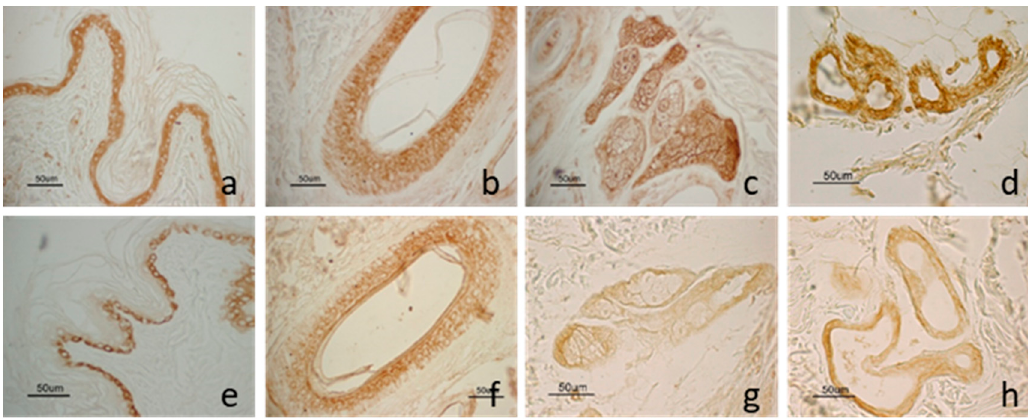
Figure 2. LEP and LEPR immunostaining in dog skin: LEP immunostaining in the epidermis ( a ); in the outer root cells of the hair follicle isthmic region ( b ); in the sweat gland ( c ) and the sebaceous gland ( d ). LEPR immunostaining in the basal cells of the epidermis ( e ); in the outer root cells of the hair follicle isthmic region ( f ); in the sweat ( g ) and the sebaceous gland ( h ).